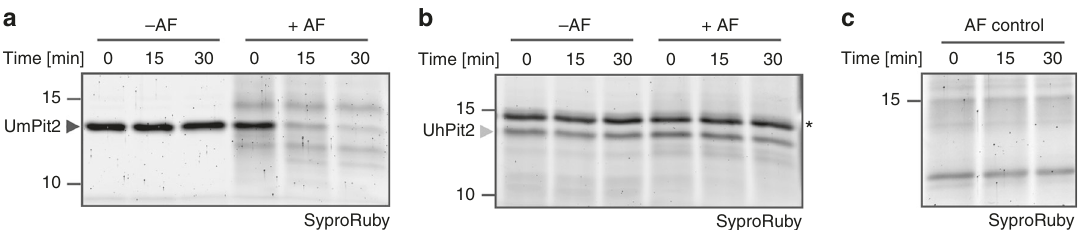
Fig. 4 UmPit2 is processed in maize apoplastic fl uids. Heterologous expressed UmPit2 ( a ) and UhPit2 ( b ) were incubated without (-AF) or with (-AF) maize apoplastic fl uids for 0, 15 and 30 min. Reactions were stopped by adding 1× gel loading buffer and samples were analyzed by gel electrophoresis and SyproRuby staining. Asterisk represents a contaminant signal from E. coli . c Apoplastic fl uid control over the time of the